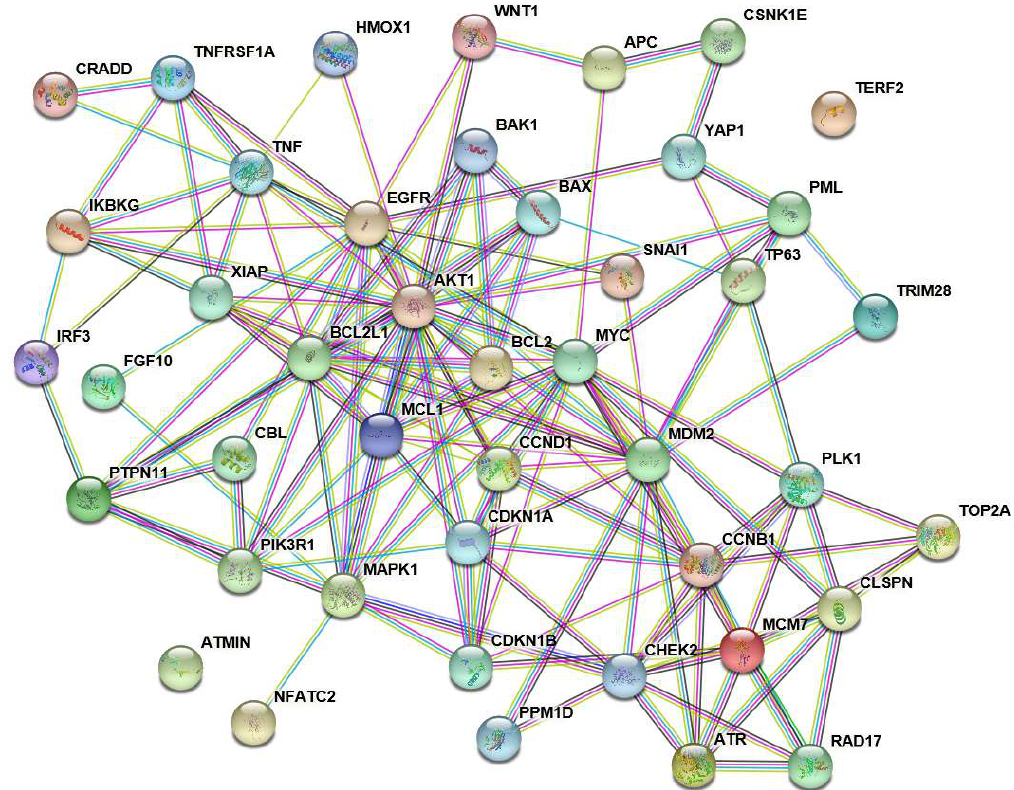
Figure 1. Workflow illustrating the selection of 44 genes associated with both clustered DNA damage and cellular response to DNA damage, after eliminating genes known to be involved in DDR.